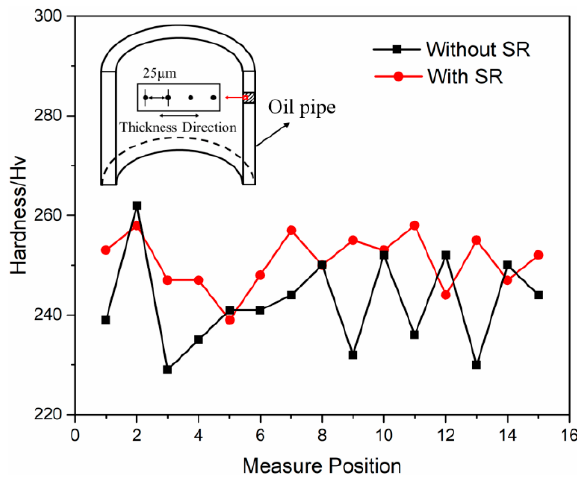
Figure 15. Hardness distribution of inner wall of oil pipe.